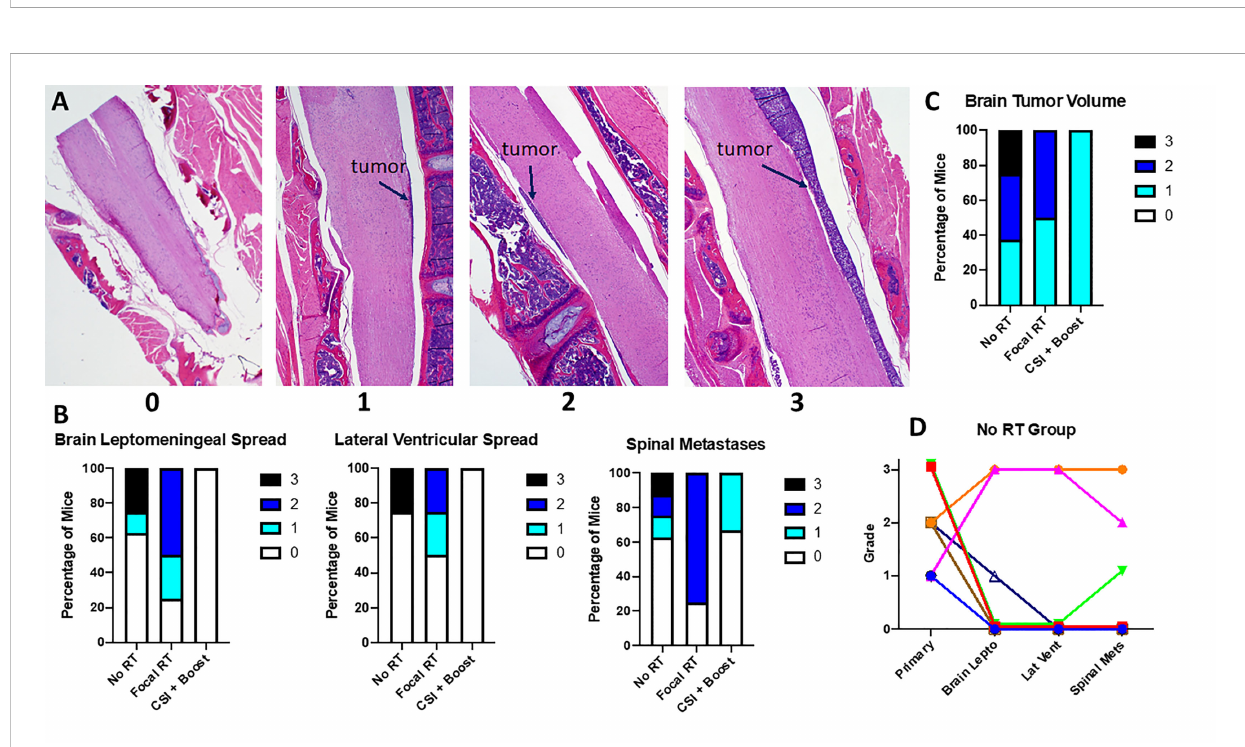
FIGURE 3 (A) Sagittal spinal cord images show examples of each gradation of metastatic disease; (B) Grading of metastases across locations for all mice by treatment group; (C) Grading of primary tumor volume for all mice by treatment group; (D) Correlation between primary tumor volume and metastatic gradation at each site measured for the no RT group; each color/shape represents a different individual